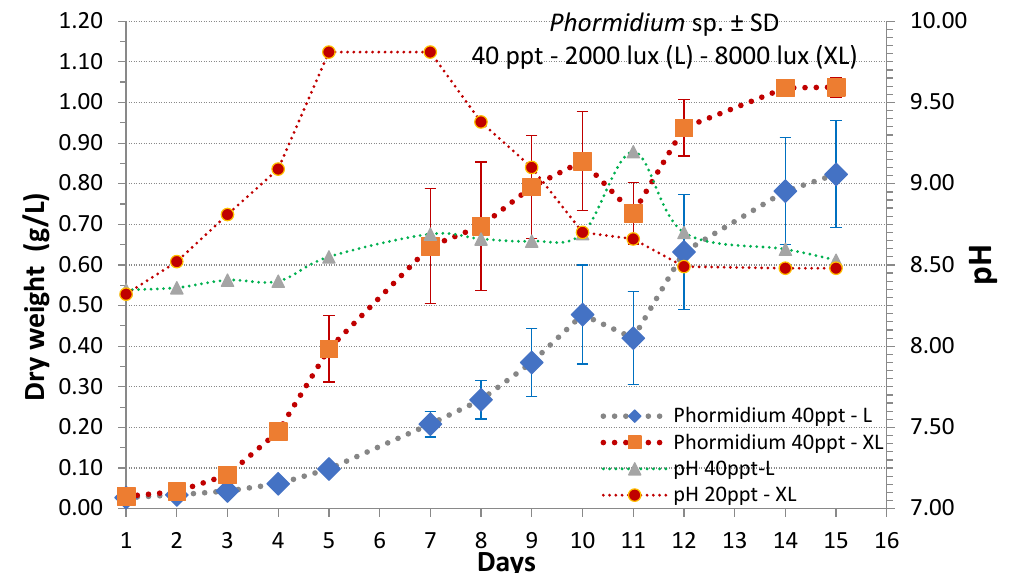
Figure 5. Growth curve and pH values for the period of a culture of Phormidium sp. at a salinity of 20 ppt in two light regimes: “ high light ” - “ XL ” -8000 lux and “ low light ” - “ L ” -2000 lux.